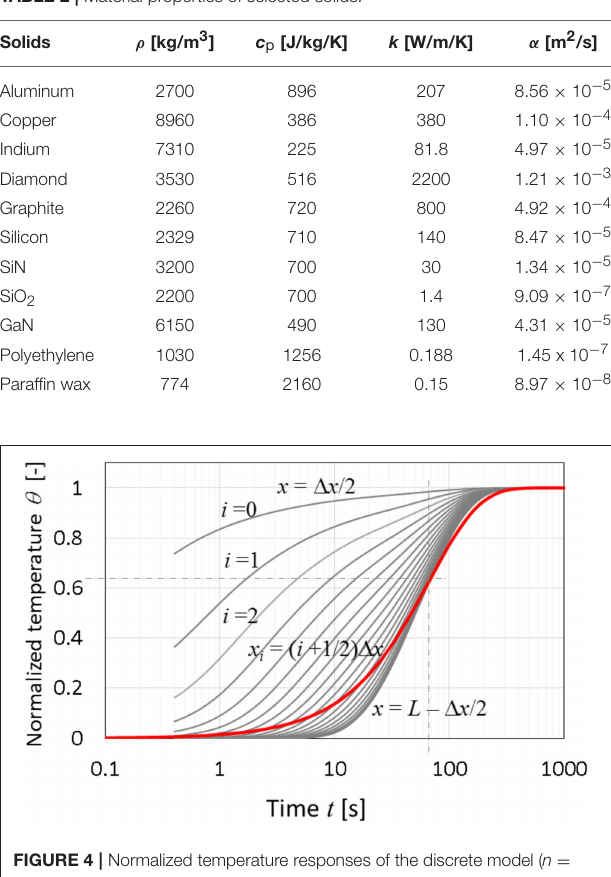
FIGURE 3 | Thermal Ragone plot for single phase materials ( Table 2 ). Impact of involving latent heat for paraffin wax (section Modeling of Phase-Change Material) is included. The values are specific to a cubic geometry with length of 0.1m surrounded by adiabatic boundaries except the heat flow face. In the calculation, initial temperature of 40 ◦ C, contact temperature of 60 ◦ C, and melting temperature (paraffin) of 50 ◦ C are used.